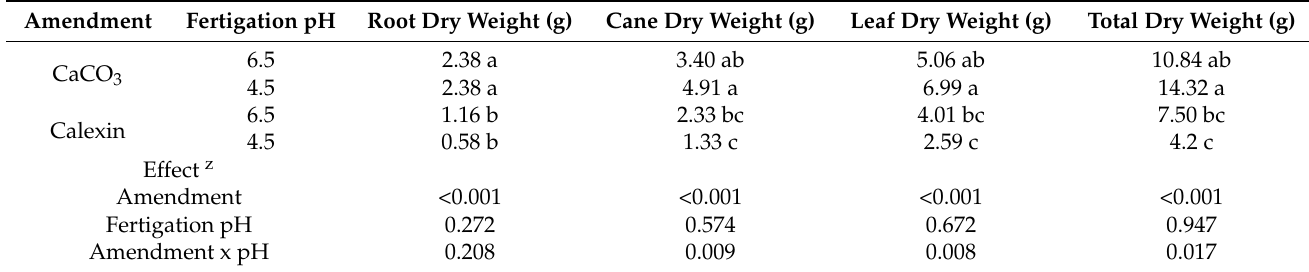
Figure 1. Leachate pH ( A ) and electrical conductivity (EC) ( B ) collected from rhizoboxes where ‘Emerald’ southern highbush blueberry grew with contrasting substrate amendments (CaCO 3 or Ca-containing fertilizer Calexin) and fertigation pH (pH 4.5 and pH 6.5). Table 3. Biomass accumulation of ‘Emerald’ southern highbush blueberry plants grown in rhizoboxes with contrasting substrate amendments and fertigation